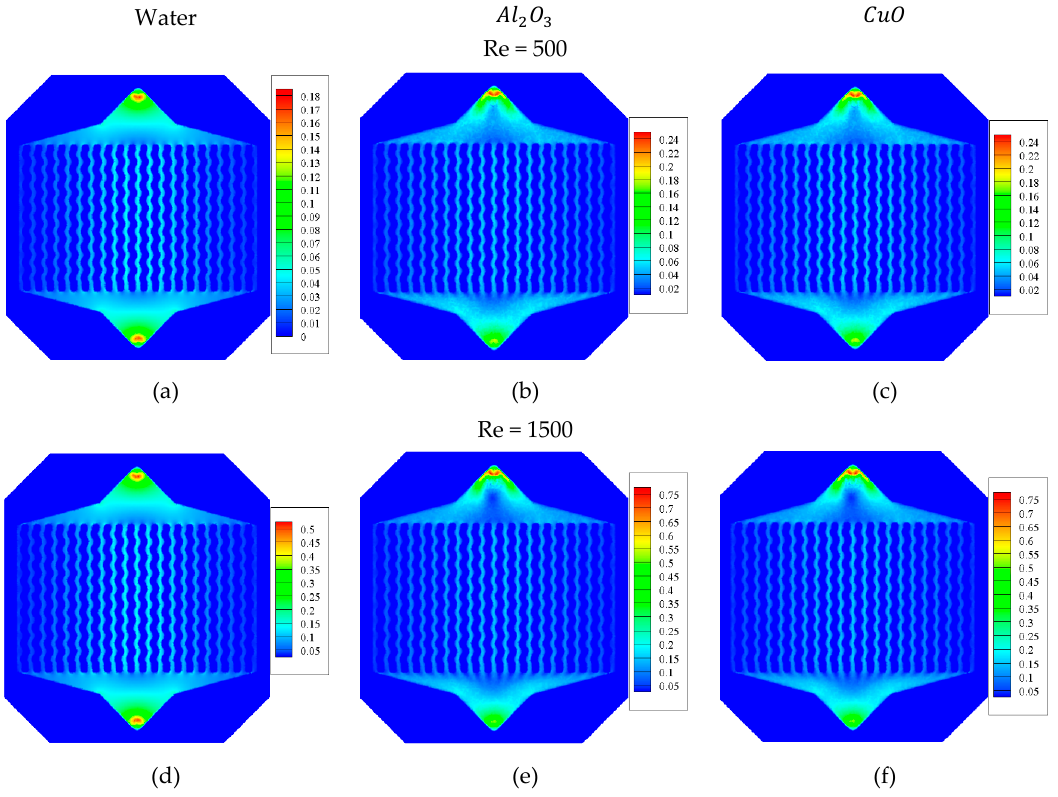
Figure 4. The velocity field for the Al 2 O 3 and CuO water-based NFs at the Res of 500 ( a – c ) and 1500 ( d – f ) on the middle plane of the WMCHS.